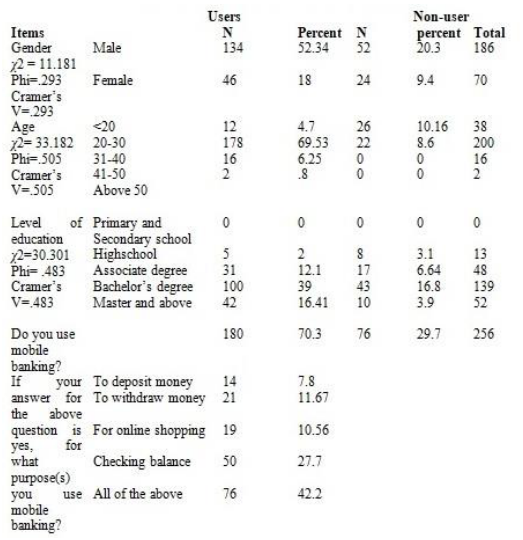
Table 3: Demographic profile of the Respondents